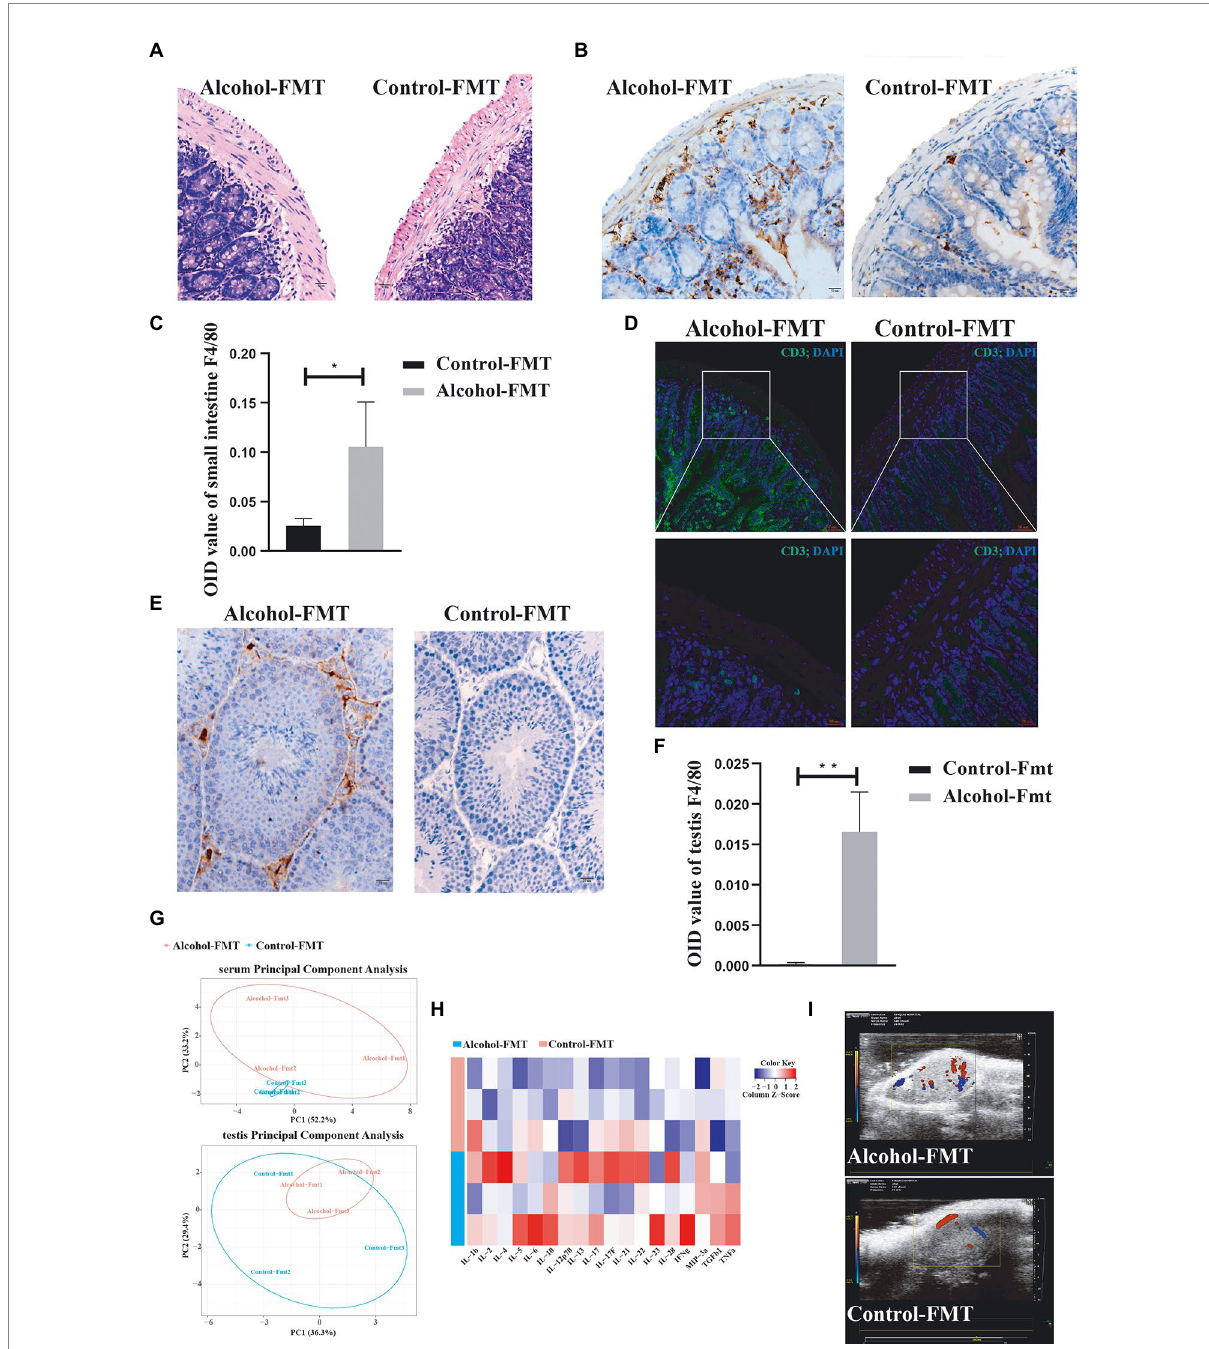
FIGURE 5 Alcohol - FMT mice showed dysbiosis of the gut microbiota, which led to intestinal CD3+ T-cell and macrophage aggregation and testis inflammation. (A) Histological examination of FMT-treated intestines. Scale bar = 50 μ m. (B) Immunohistochemical determination of macrophage infiltration in the small intestines. Scale bar = 50 μ m. (C) F4/80 histological score. (D) Immunofluorescence staining for CD3 (green) was performed in the small intestine samples. Nuclei were stained with DAPI (blue). The lower panels show higher magnification images of the upper panels. Scale bar = 20 μ m. (E) Immunohistochemical determination of macrophage infiltration in the testis. Scale bar = 50 μ m. (F) F4/80 histological score. (G) PCA of the serum and testis inflammatory factors. (H) Heatmap of the abundance of 18 inflammatory factors. (I) Ultrasonic evaluation of testicular blood flow using the Vevo 2,100 imaging system. Red and blue represent blood flow; red represents positive blood flow, and blue represents reverse blood flow. * p < 0.05 and ** p <